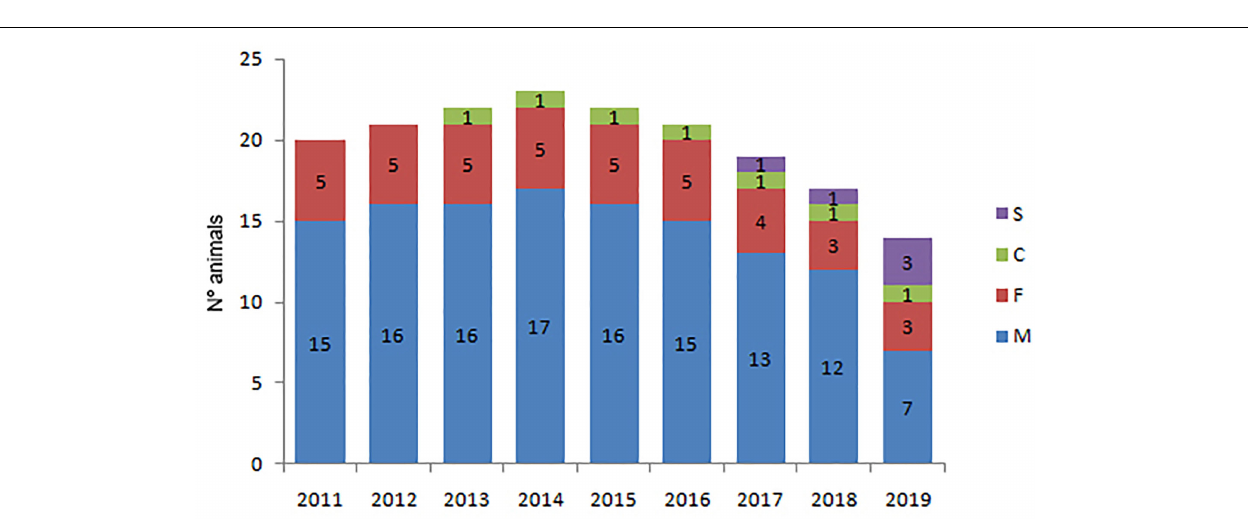
FIGURE 6 | Number of individuals per age and sex class in the Posorja community during the period 2011–2019 M = adult males, F = adult females, S = subadults, C =